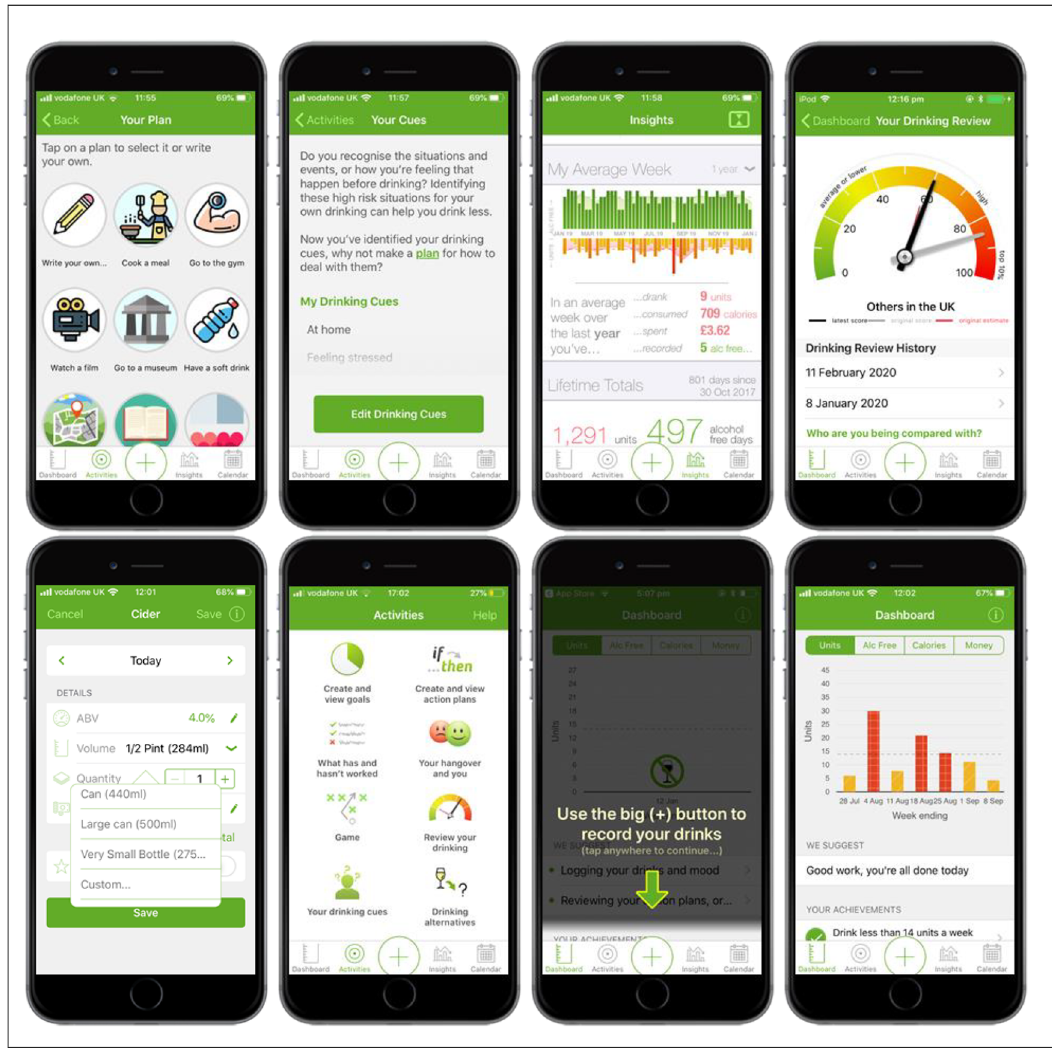
Figure 2. Screenshots from the refined version of the Drink Less